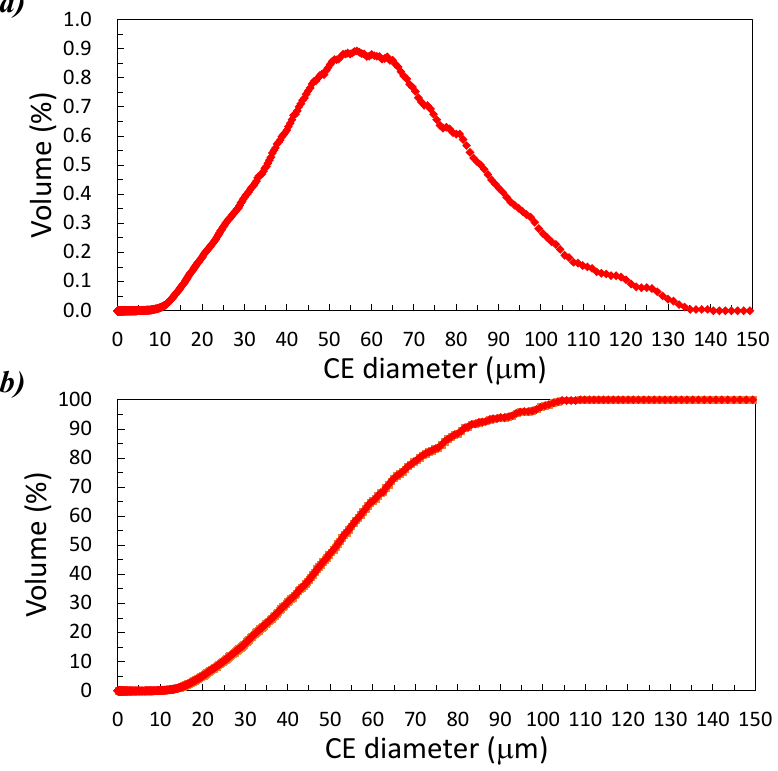
Figure 2. ( a ) Frequency particle size distribution (PSD) and ( b ) cumulative PSD on a volume basis as function of the equivalent circle particle diameter